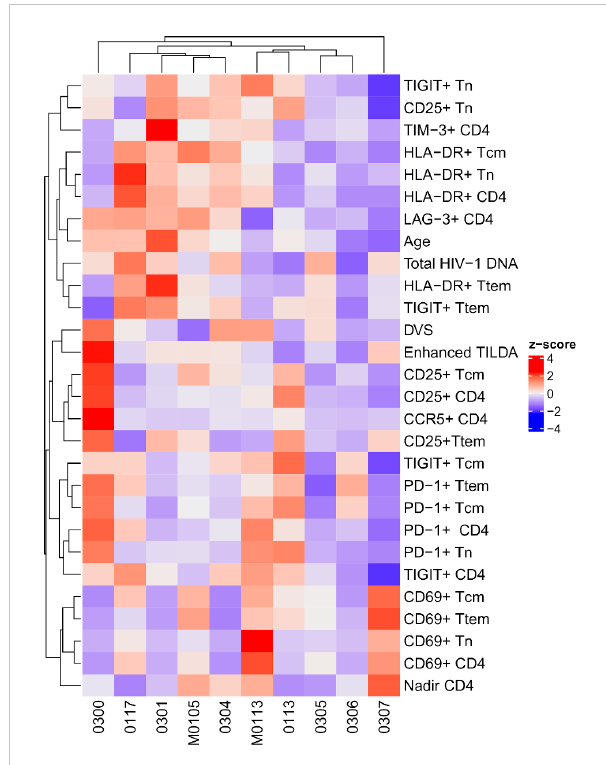
FIGURE 3 Clustering of the percentage of CD4+ T cells subsets, demographics, total HIV-1 DNA and enhanced TILDA. The heatmap shows the standardized values (z-scores) of each assay measurement across patients. The assays and patients were clustered using hierarchical clustering based on the z-scores. DVS, Duration of virologic